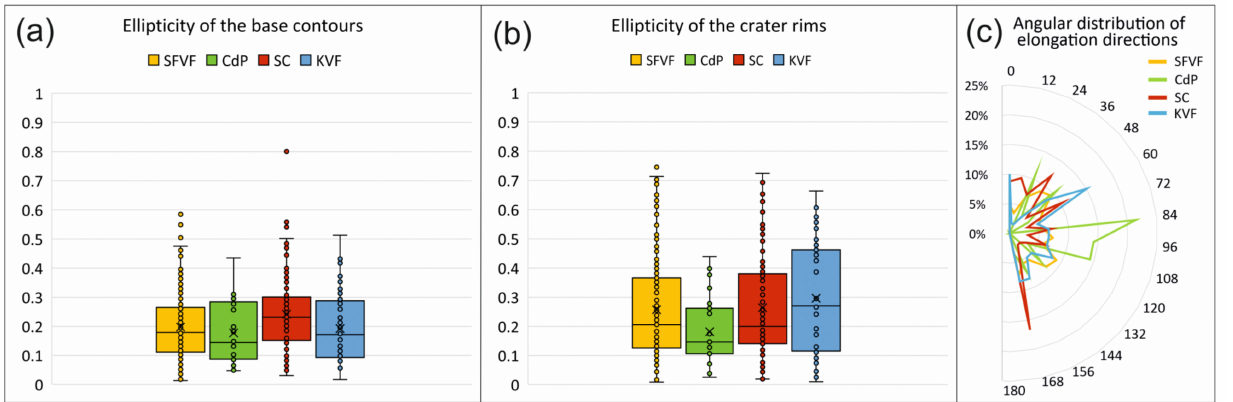
Figure 10. Ellipticity of ( a ) base contours and ( b ) crater rims; ( c ) orientation of symmetry axes of the base